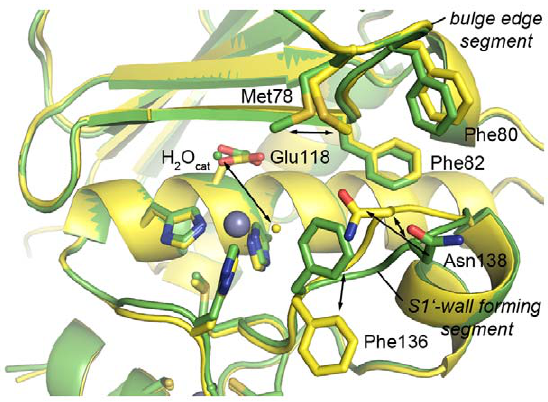
Figure 5. The two conformations of Af AmzAs substrate-binding site. Superposition of NHis- Af AmzA (yellow) and nat- Af AmzA (green) substrate binding site. Changes in the position of side chains in the bulge edge segment (Met78, Phe80,82), side chains and the main chain of the S1 9 -wall forming segment (Phe136, Asn138) and in the position of the catalytic water molecule (H 2 O cat) are indicated by the